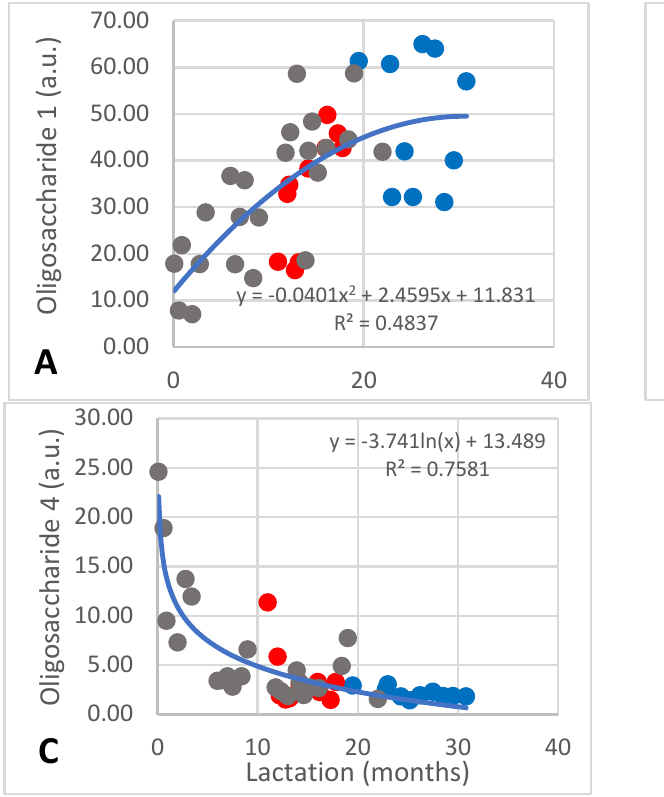
Figure 3. Changes of unidentified oligosaccharides 1, 3, and 4 (( A ), ( B ), and ( C ), respectively) in milk of African elephants (Shorty ● , Mussina ● , Shan ● ). Trend lines, formulas, and R 2 values were calculated from the combined data of the three elephants.